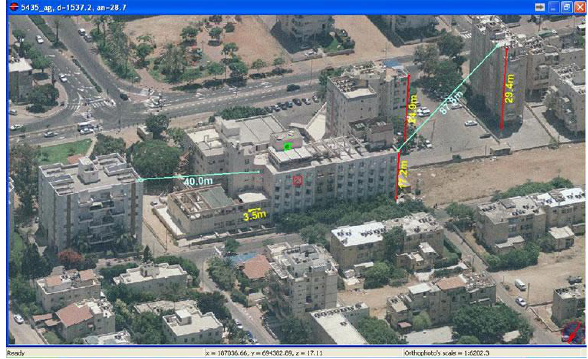
Figure 5. Height and distance measurements (Aeromap, 2006) In terms of military and security operations, oblique photogrammetry strengthens the management by providing critical site information as well as information on surrounding areas and infrastructure. During crises, access and evacuation